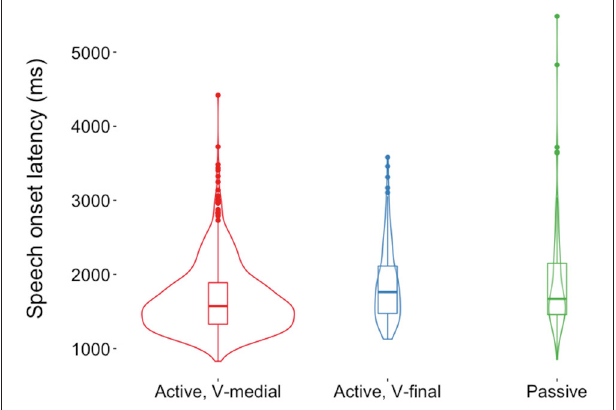
FIGURE 3 | Densities and box plots of speech onset latencies (relative to stimulus picture onset) for three German sentence types; width of the violins is proportional to the number of underlying data points (Hintze and Nelson, 1998).